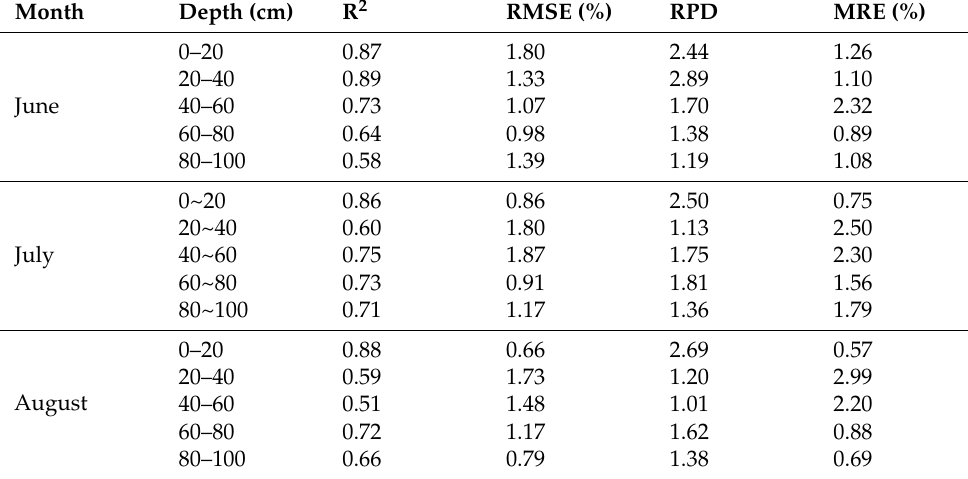
Table 3. Indices of cross-validation Soil Moisture Model. Note: R 2 , coefficient of determination; RMSE, root mean square error; RPD, Relative percent deviation; MRE, Mean relative error. Month Depth (cm) R 2 RMSE (%) RPD MRE (%) 0–20 0.87 1.80 2.44 1.26 20–40 0.89 June